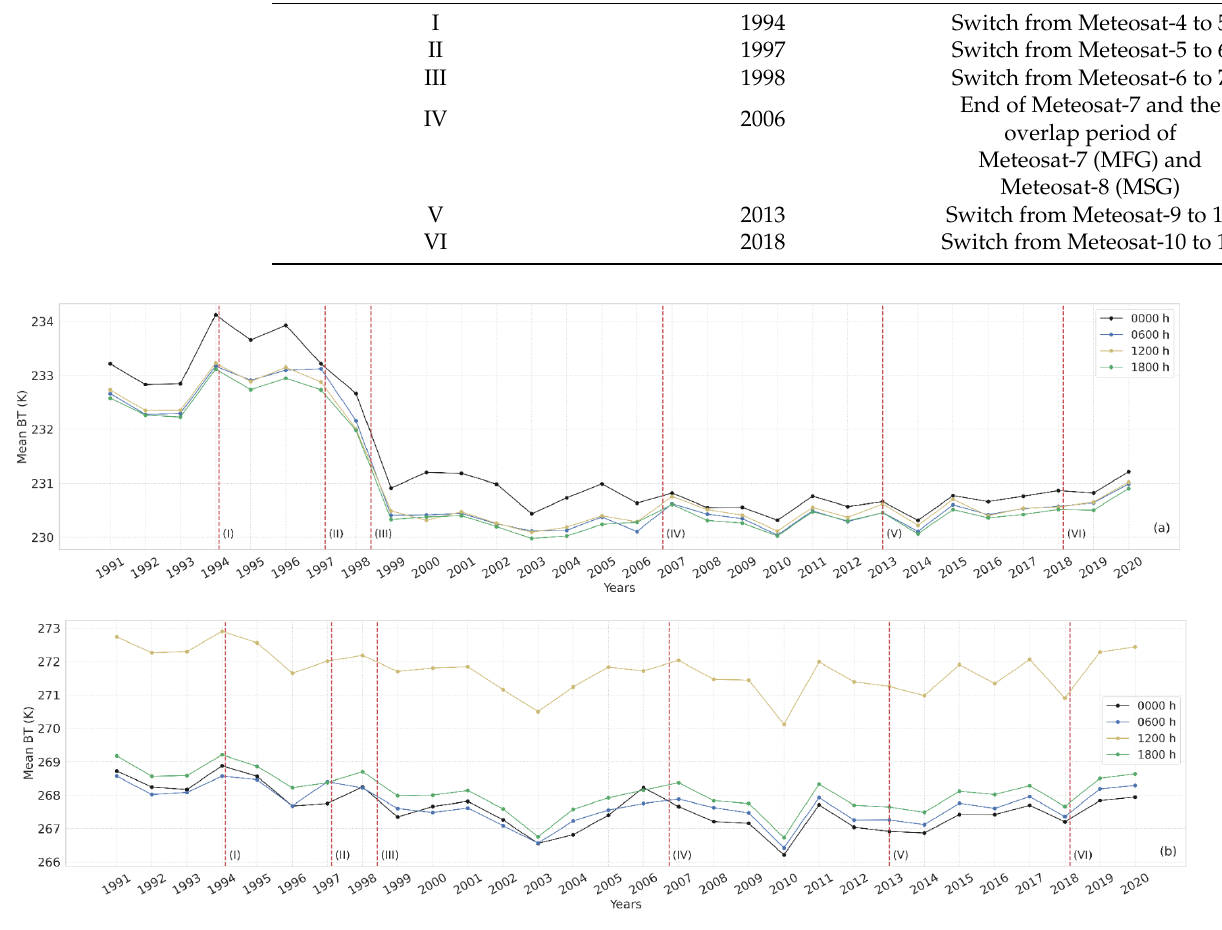
Figure 15. Time series plot (1991–2020) of mean BT values (K) for ( a ) WV and ( b ) IR channel. Red dotted lines represent the checkpoints (I to VI) placed whenever there is a change in Meteosat satellites (e.g., Meteosat-4 to -5 and so on) to check for homogeneity of the entire dataset by comparing the mean BT values before and after the change of